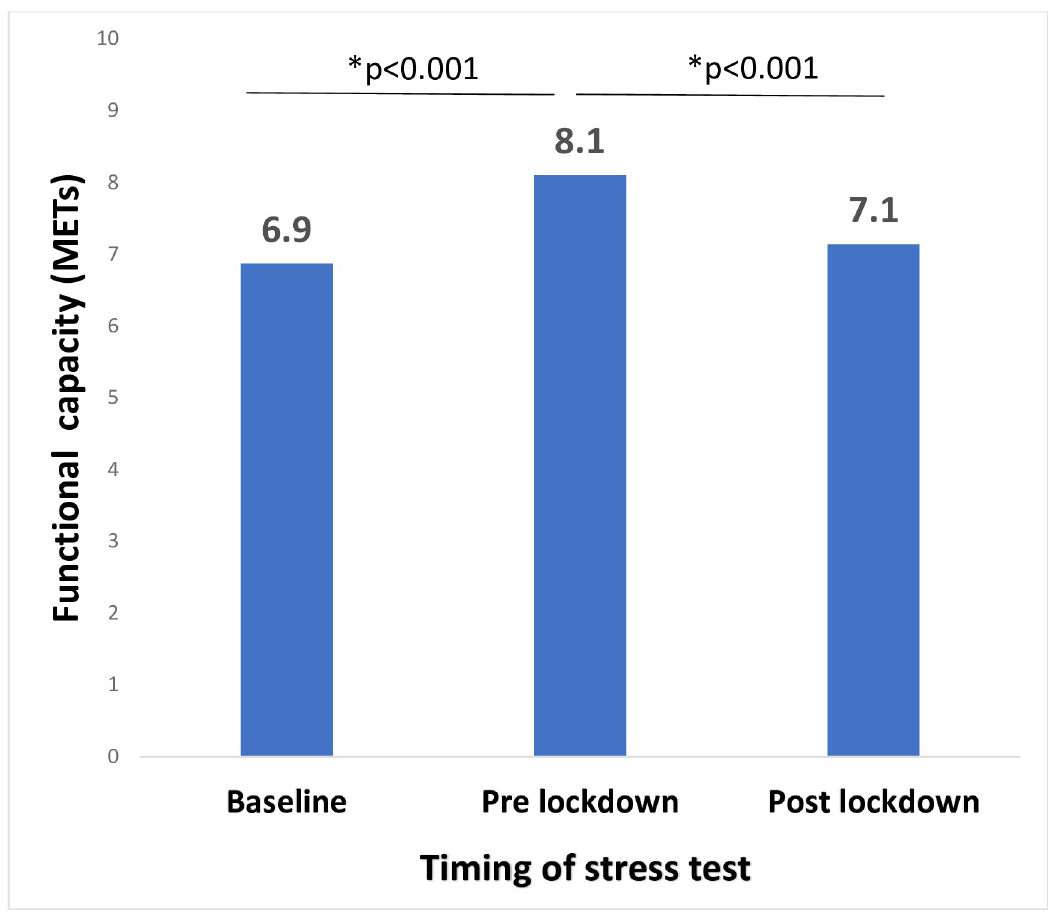
Fig 1. Exercise capacity at baseline, pre-lockdown, and post lock down measurements (n = 198).